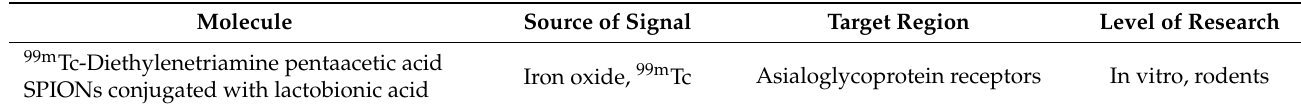
Table 2. Iron oxide-based SPECT contrast agents as described in Molecular Imaging and Contrast Agent Database [15].